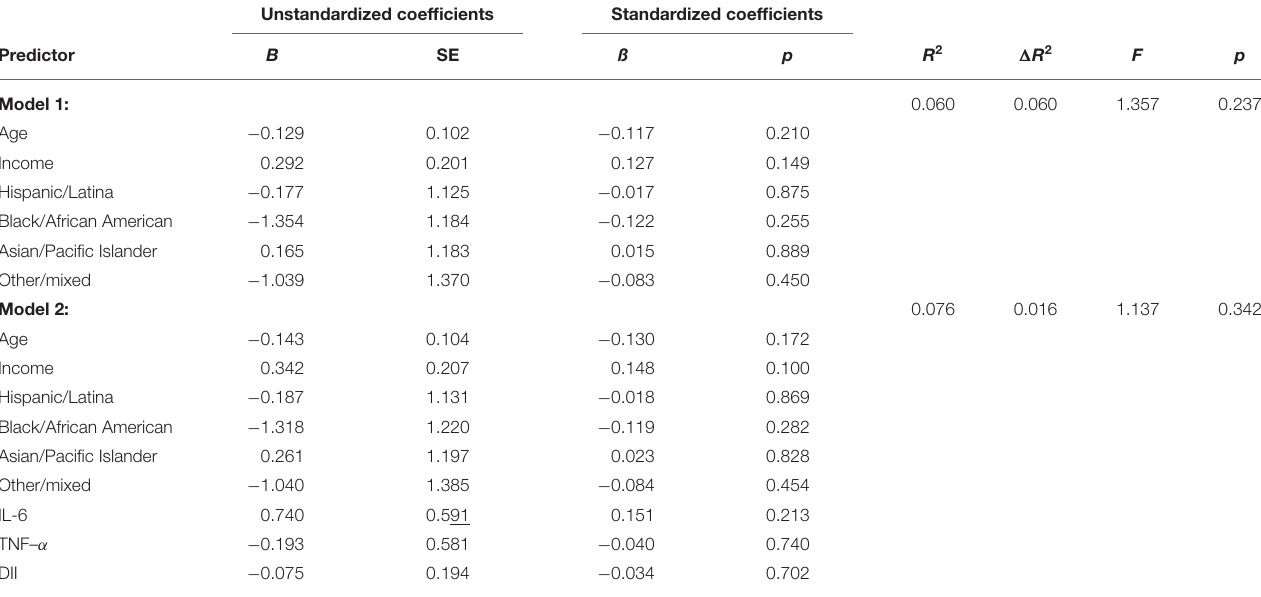
TABLE 5 | Summary of multiple regression analysis examining the adjusted relationship between inflammation variables and the cognitive dimension. Unstandardized